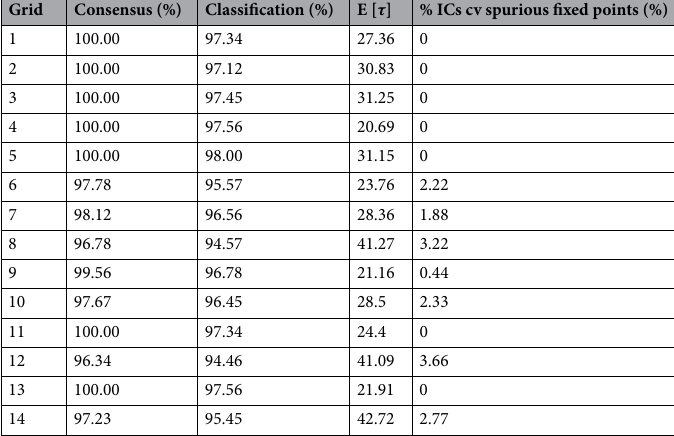
Table 1. Percentage of initial configurations that converge to spurious fixed points.